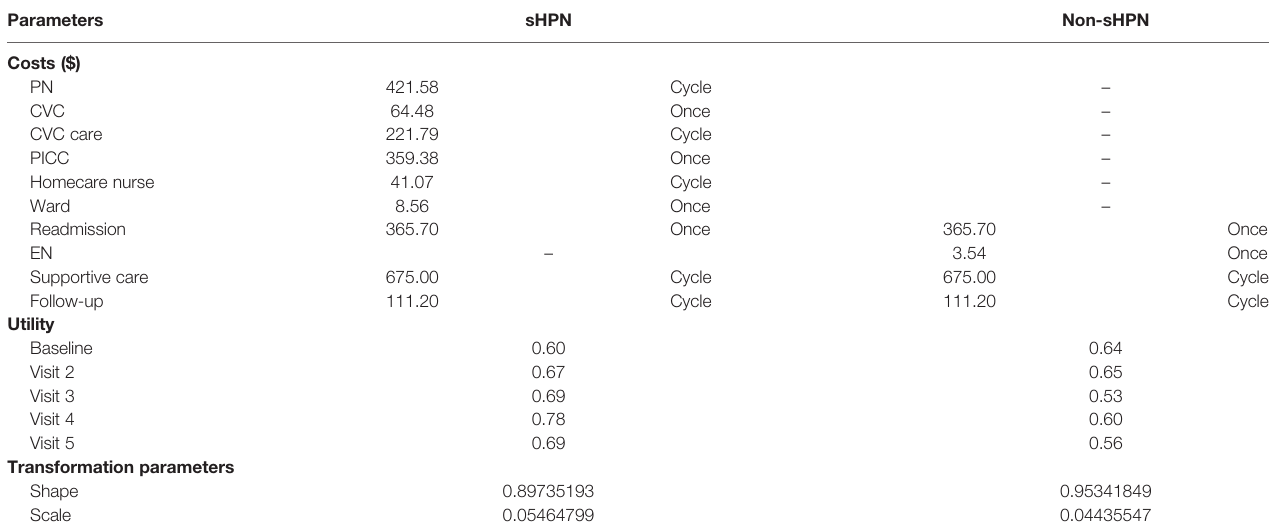
TABLE 1 | Parameters of cost-effectiveness